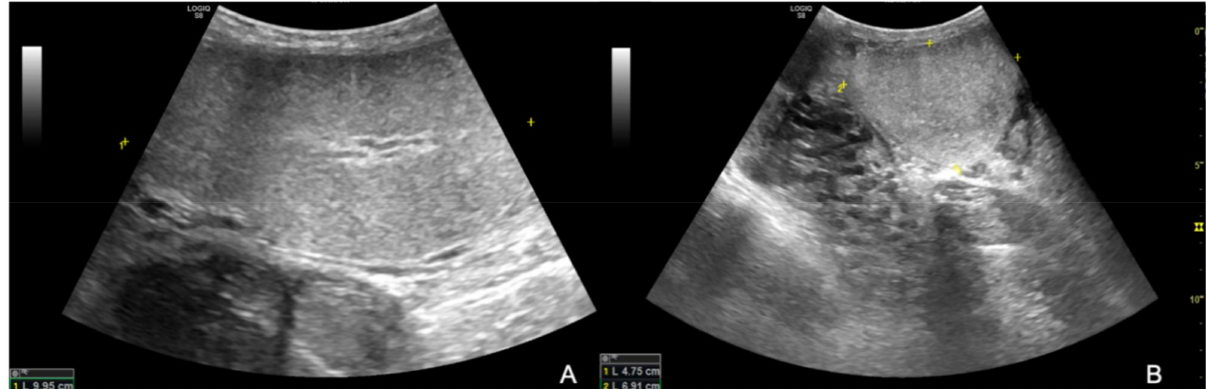
Figure 2. B-mode longitudinal ( A ) and transverse ( B ) images of the right testicle; note the homoge- neous appearance of normal testicular parenchyma.